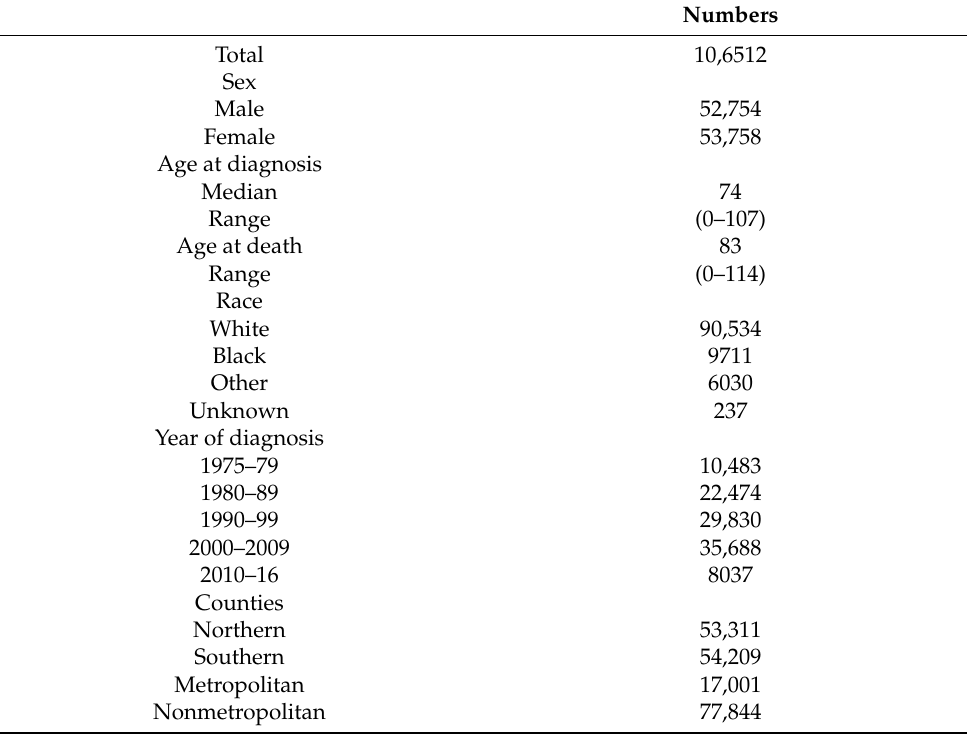
Table 1. Demographic characteristics of the included cancer patients with death due to the fact of cerebrovascular